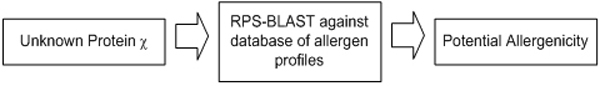
General strategy of the profile-based method. The general strategy involves performing a RPS-BLAST search on the query protein against a searchable database of allergen profiles generated by PSI-BLAST. Query sequences that generate hits above the specified e-value threshold are predicted to be potential allergens.